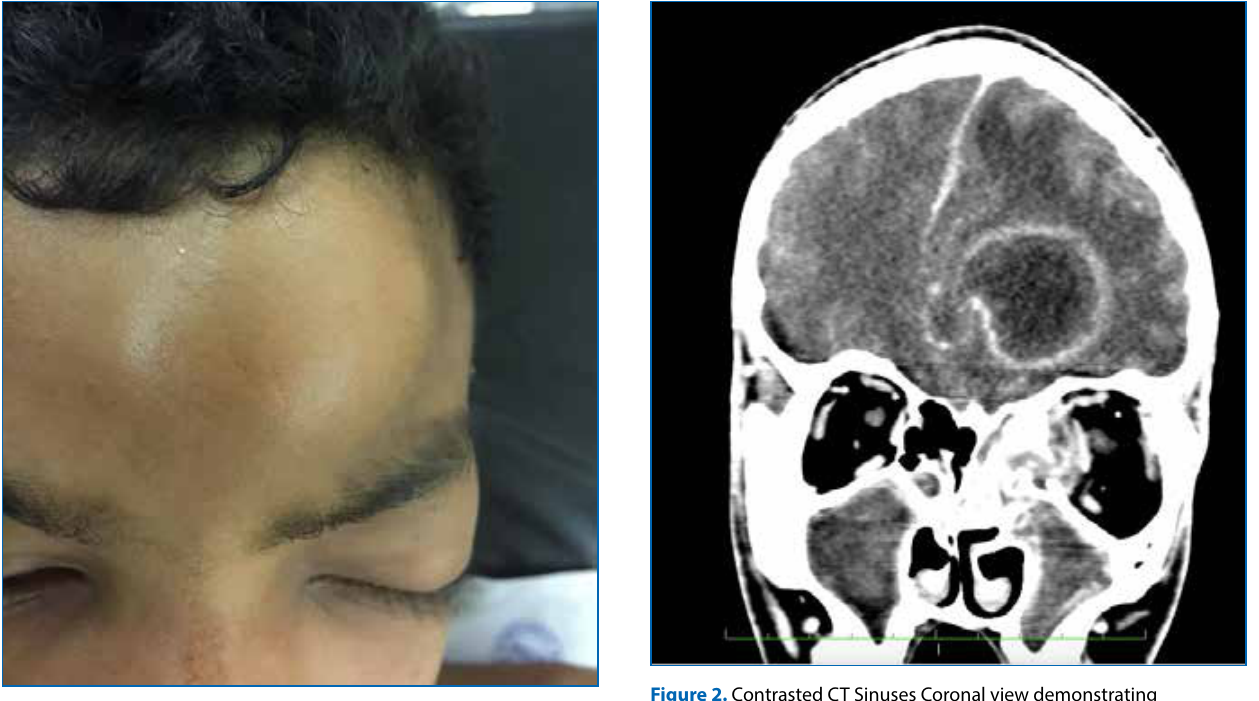
Figure 1. Pott’s Puffy tumour in an adolescent